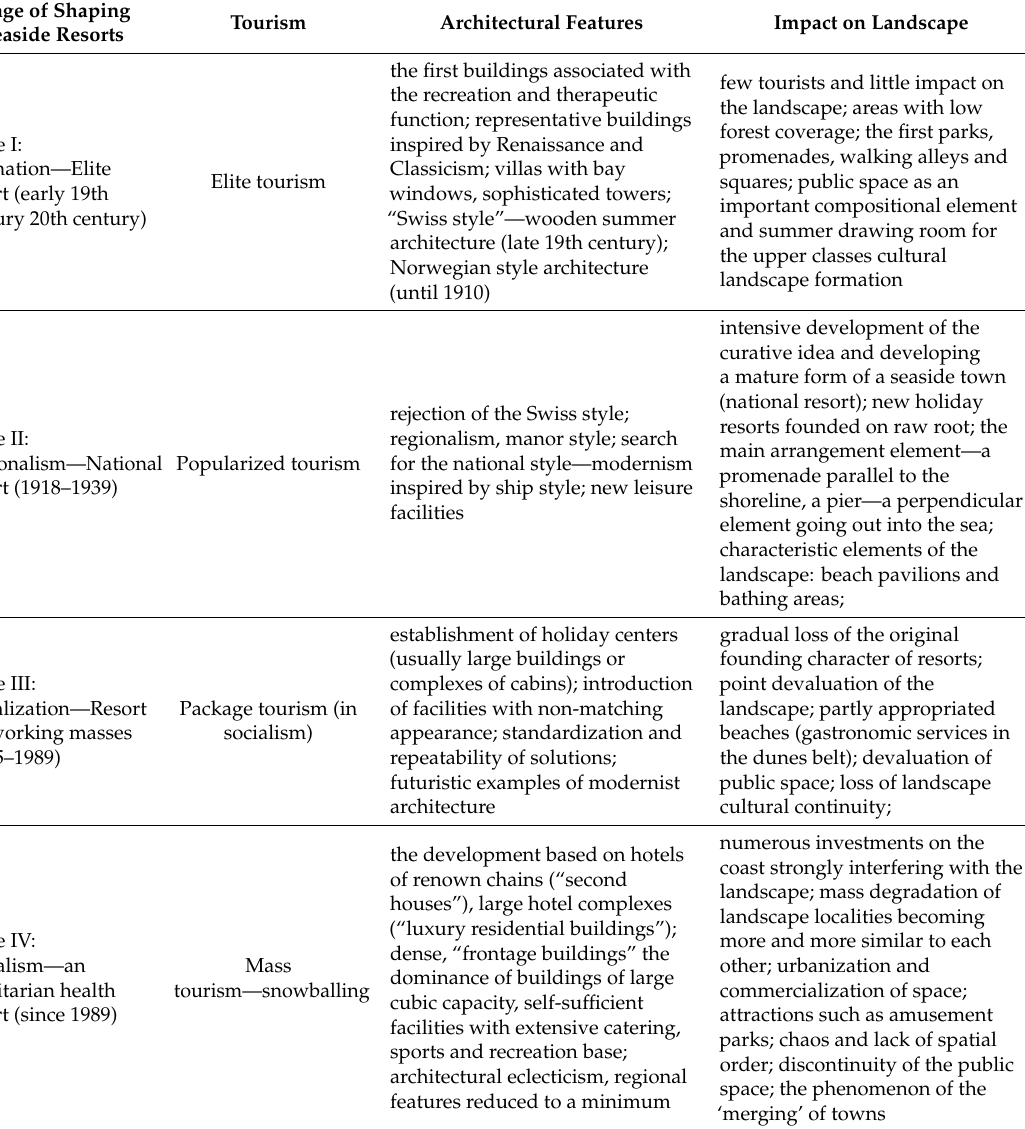
Table 2. Stages of cultural landscape transformations of seaside resorts in Poland—landscape and architectural features. Source: Authors’